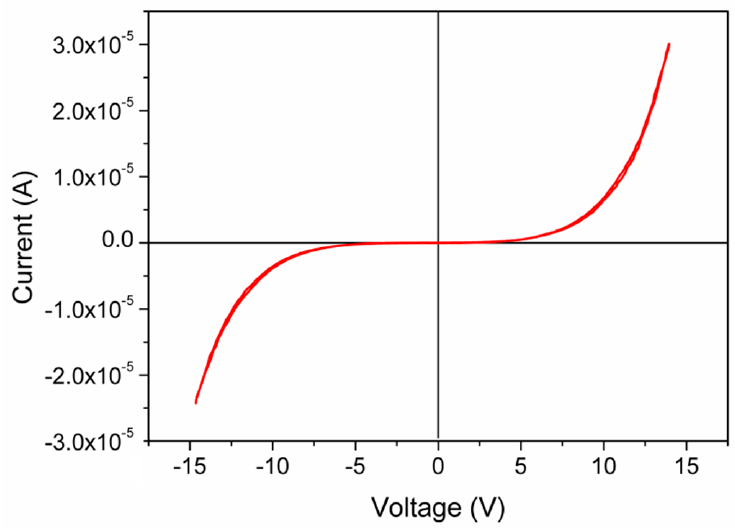
Figure 4. IV curve measured on a 700 nm-thick ZnO thin film.